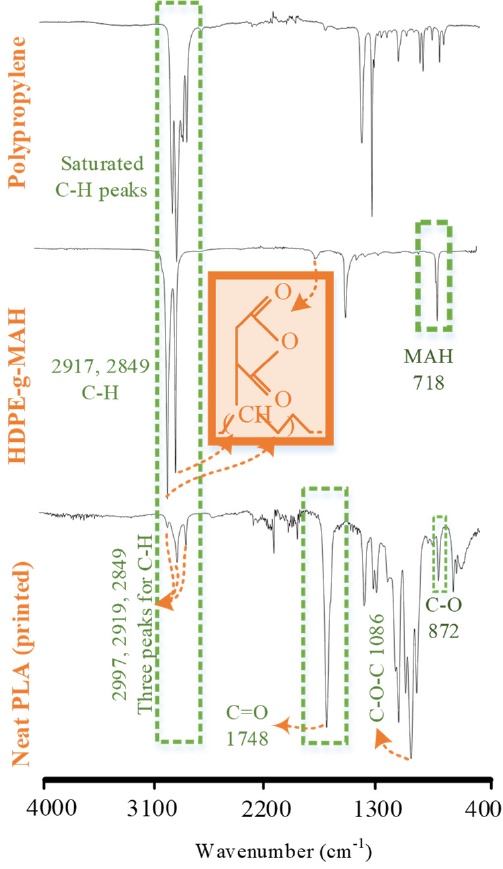
Figure 6. FTIR analysis of neat polymers. FTIR spectra of the blend printed at the low-temperature combination and the high- temperature combination were compared with the neat PLA (Figure 7). The melt blending Table 6. FTIR analysis (“WN” stands for wave number, cm − 1 , and “I” stands for intensity). reports the intermolecular interactions in different